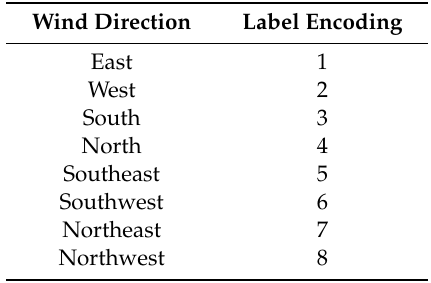
Table 2. The label encoding of the wind